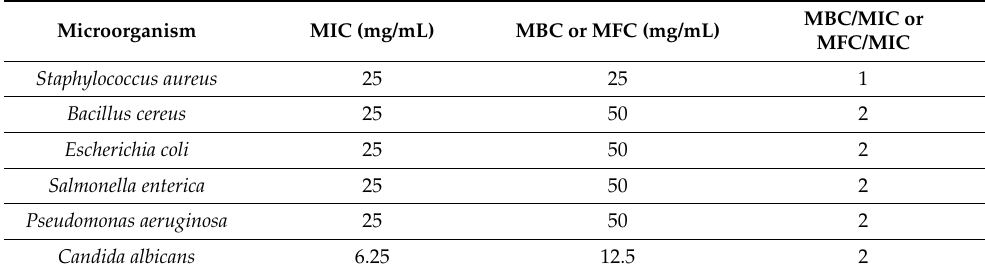
Table 3. The MIC, MBC, MFC, MBC/MIC, and MFC/MIC values of the acetic acid extract of Saussurea costus against the examined microorganisms. Microorganism MIC (mg/mL) MBC or MFC (mg/mL)